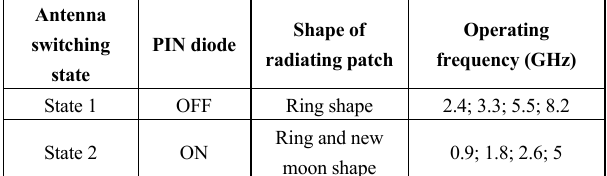
TABLE III. Comparison of two switching states